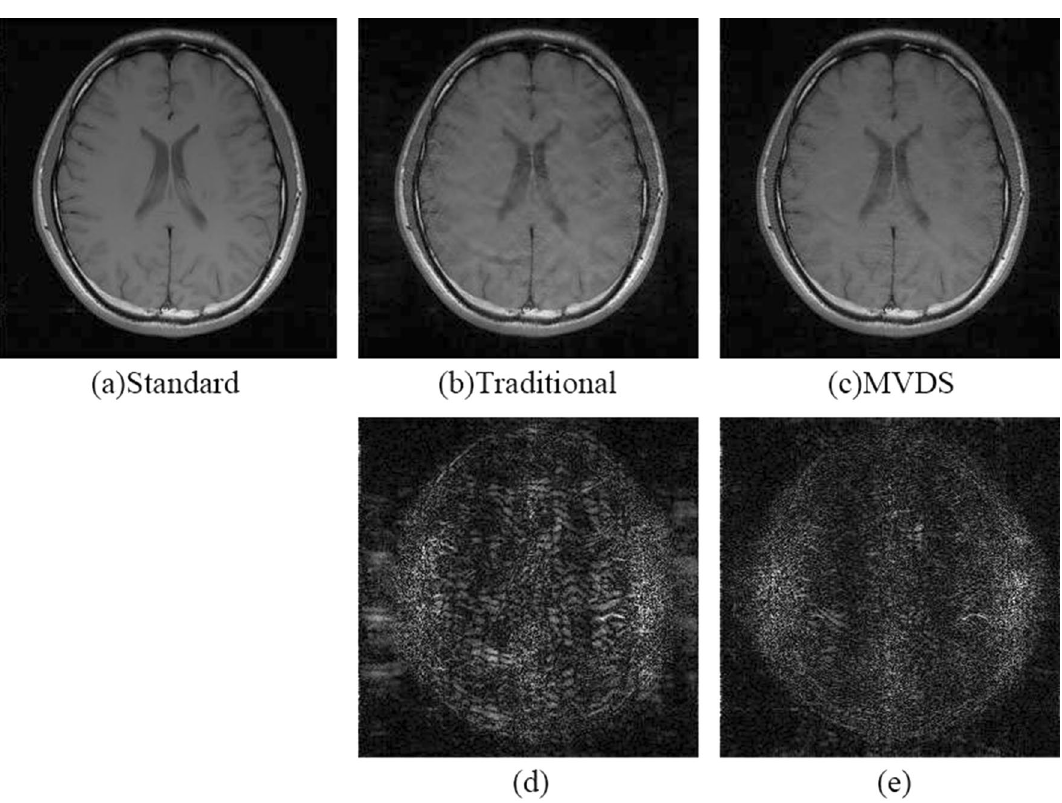
Figure 6. When R = 6 and ACS = 24, use NL-GRAPPA to reconstruct the image to compare traditional and MVDS methods. ( a ) The original standard reference image. ( b ) The traditional method, and ( d ) is the corresponding difference image. ( c ) The MVDS method and sampled 13 lines of data with ORF = 4 and ORF = 8, ( e ) is difference